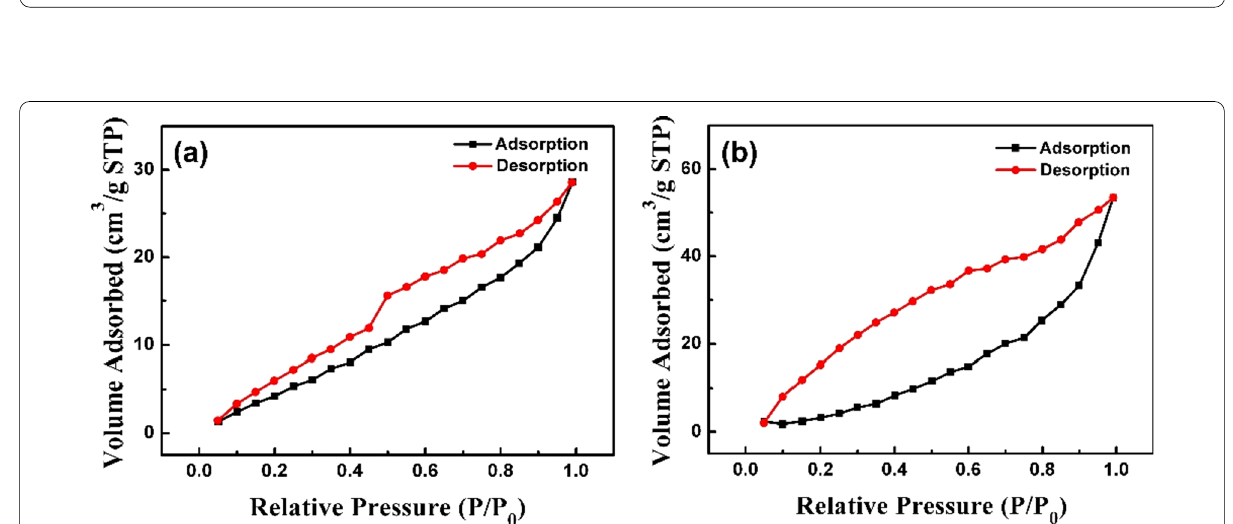
Fig. 8 a N 2 adsorption–desorption isotherm of AgZnO hybrid nanoparticles, b N 2 adsorption–desorption isotherm of AgZnO/POMs